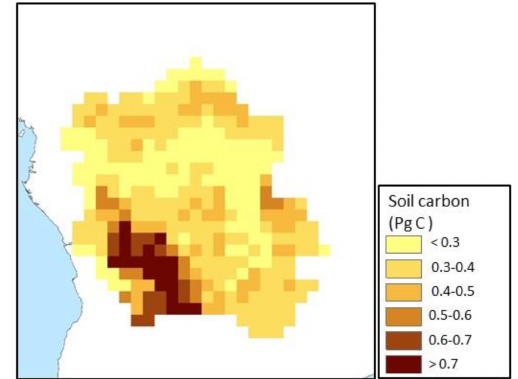
Figure A3. Spatial distribution of simulated total carbon stored in soils for the present day